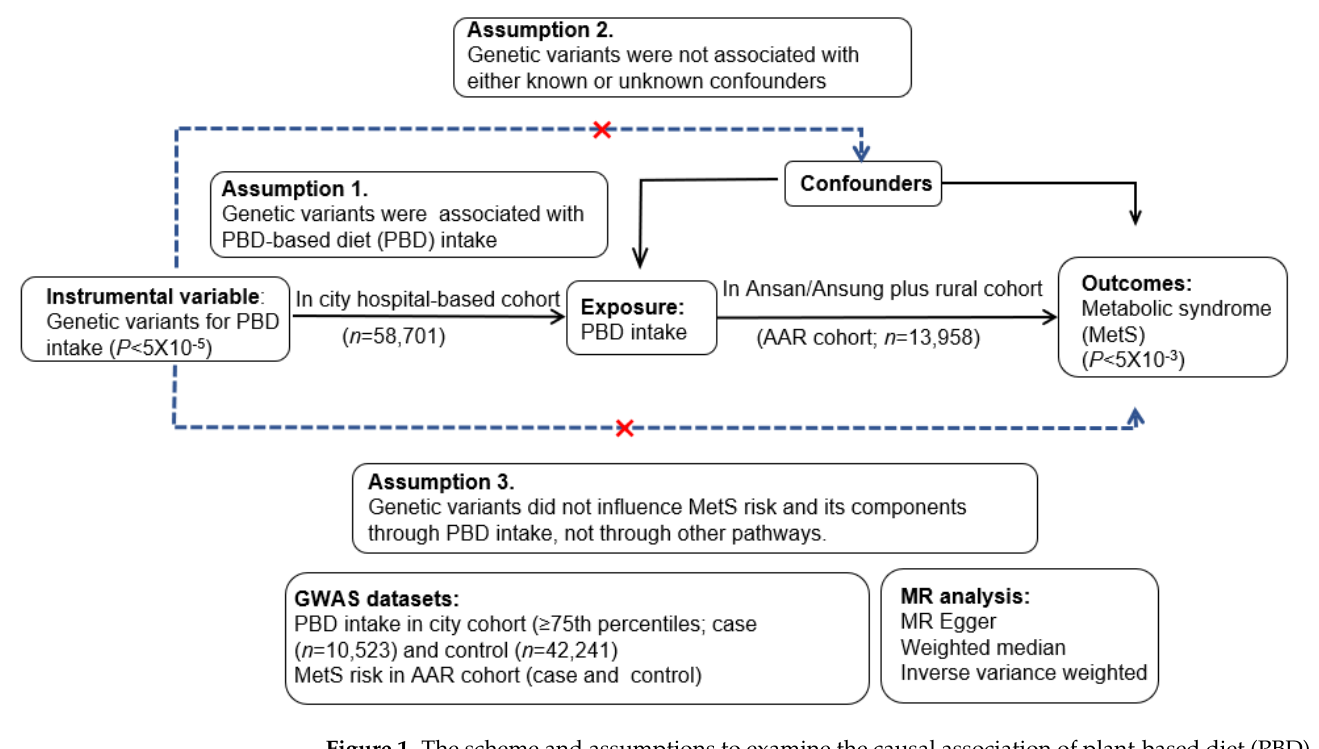
Figure 1. The scheme and assumptions to examine the causal association of plant-based diet (PBD) intake with metabolic syndrome (MetS) and its traits using two-sample Mendelian randomization (MR) analysis. The present study met all three assumptions of the MR analysis.